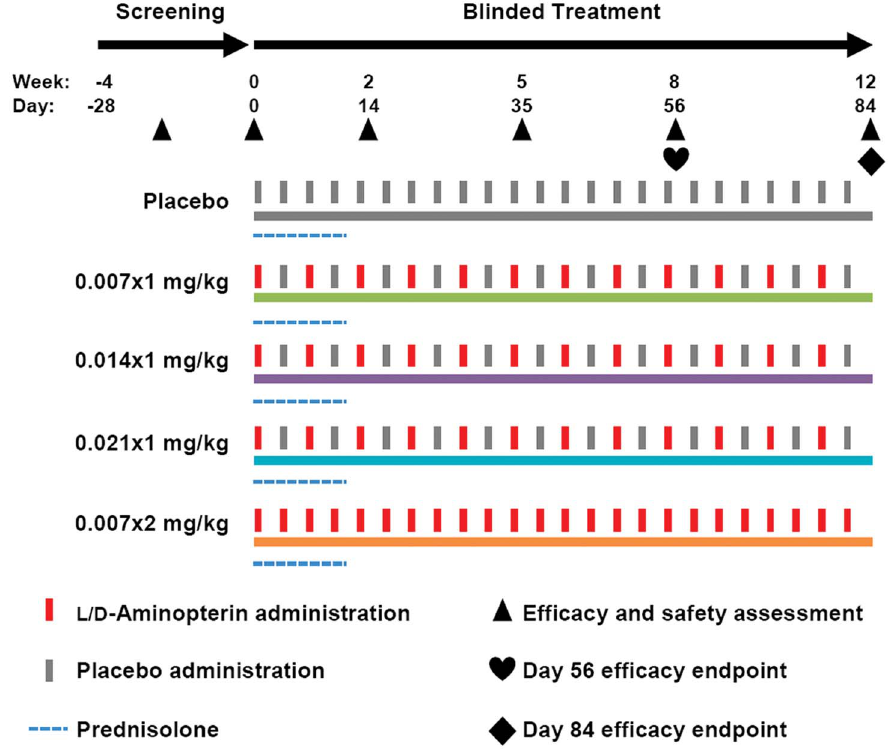
Figure 2. Study flow chart. Randomized subjects with AD were orally administered placebo, or LD-aminopterin once-weekly (0.007 6 1 mg/kg, 0.014 6 1 mg/kg, 0.021 6 1 mg/kg) or twice-weekly (0.007 6 2 mg/kg).